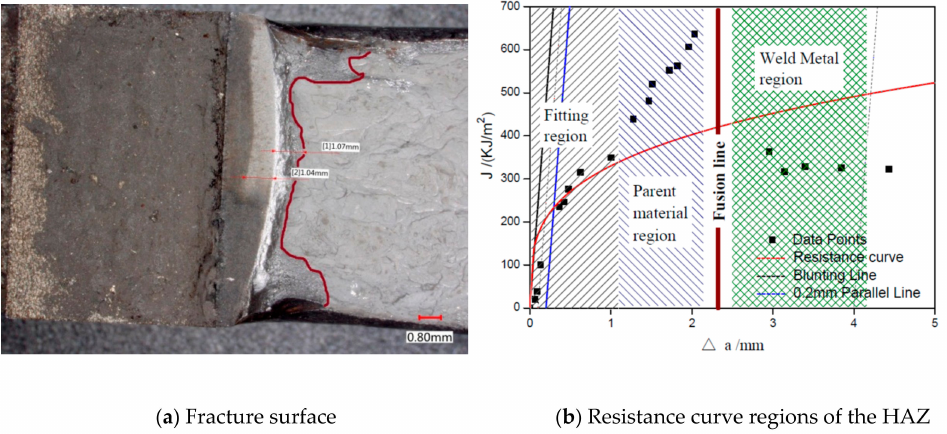
Figure 15. Fracture toughness results of the HAZ. ( a ) Fracture surface; ( b ) Resistance curve regions of the